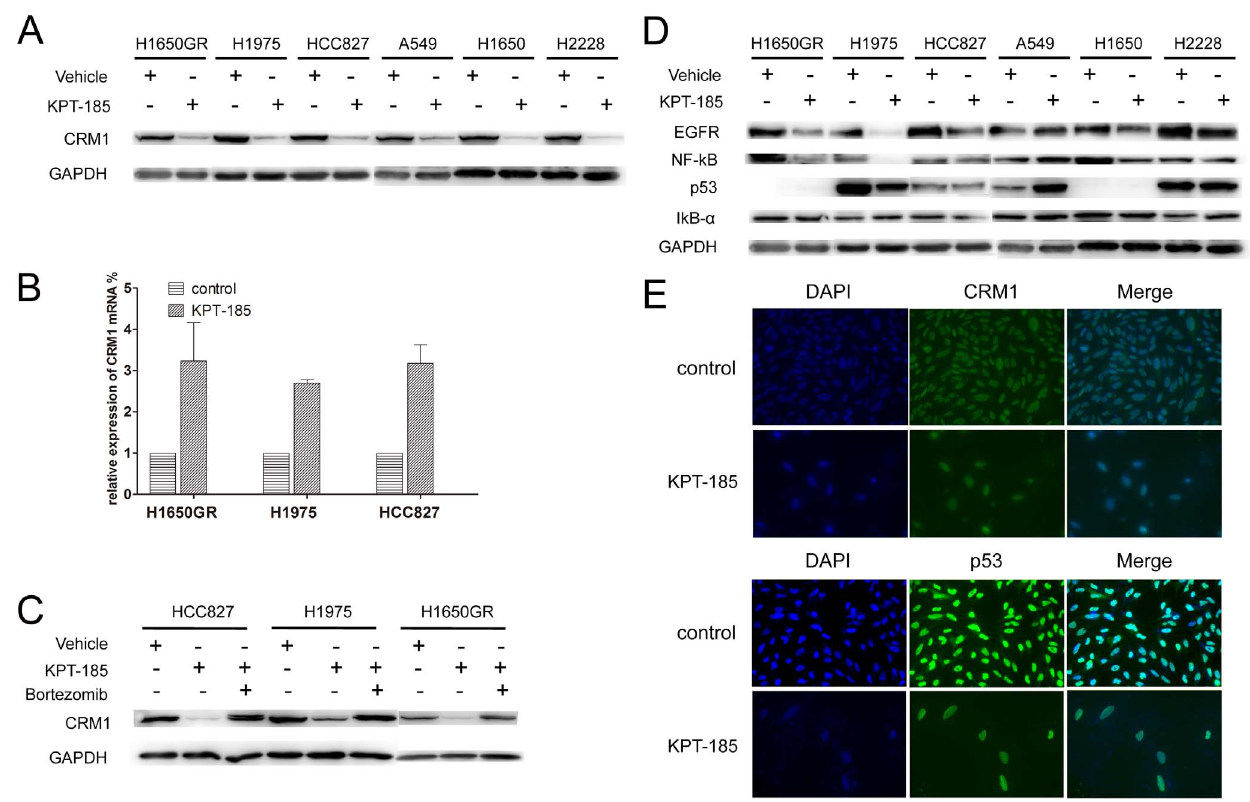
Figure 4. Effect of KPT-185 on the regulation of protein expression in NSCLC cells. The six NSCLC cell lines were treated with KPT-185 for 48 h. The expression of CRM1 protein was down-regulated (A & E), while the CRM1 mRNA levels were up-regulated (B, N=3). In the presence of the proteasome inhibitor bortezomib, the reduction of CRM1 protein following KPT-185 treatment was almost blocked in H1975, HCC827, and H1650GR cells (C). EGFR expression was downregulated following KPT-185 treatment. The NF- k B and I k B- a proteins levels were not significantly affected. KPT- 185 upregulated wild type p53 in A549 cells, downregulated mutant p53 in H1975 cell, and there was no effect in HCC827 and H2228 cell. In addition, p53 was not detected in H1650 and H1650GR cells (D&E, 400 6 ).